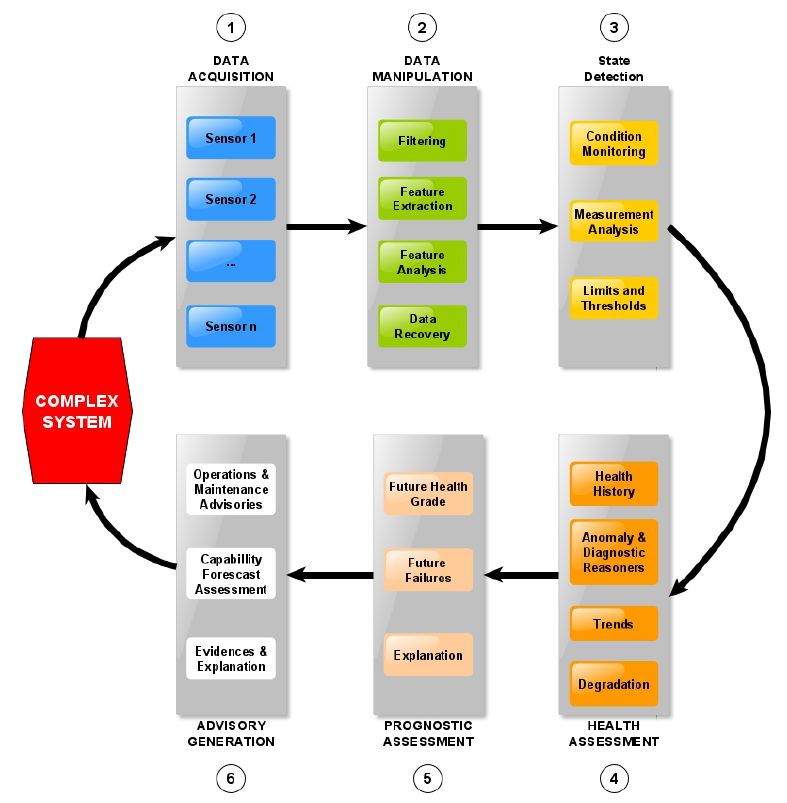
Figure 1. Open System Architecture for Condition-Based Maintenance (OSA-CBM)